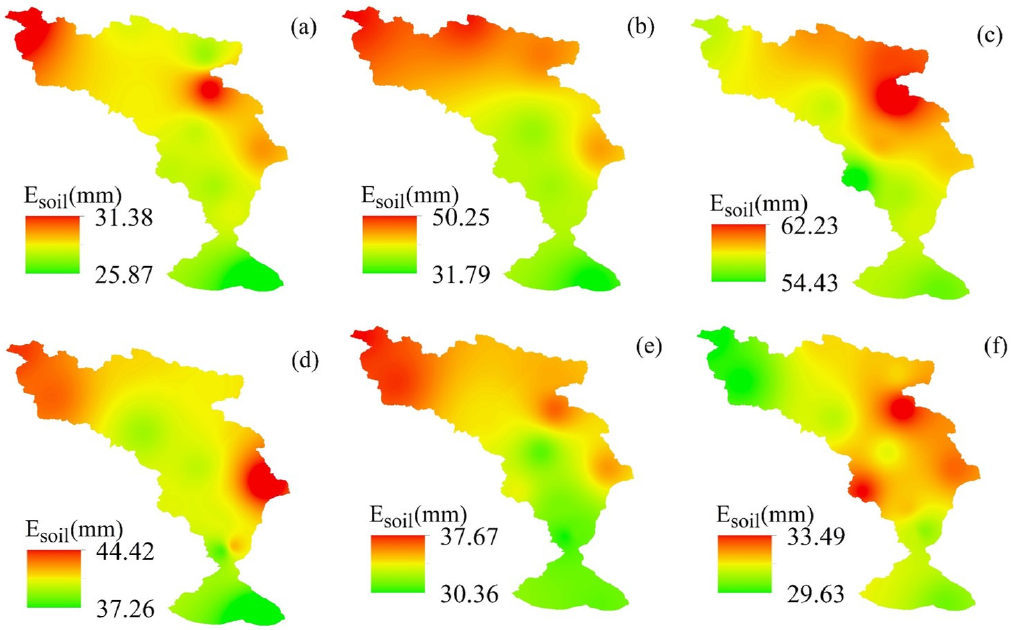
Figure 6. Spatial variation of soil evaporation value ( E soil ) in summer 2018 ( a – c ) and 2019 ( d – f ).